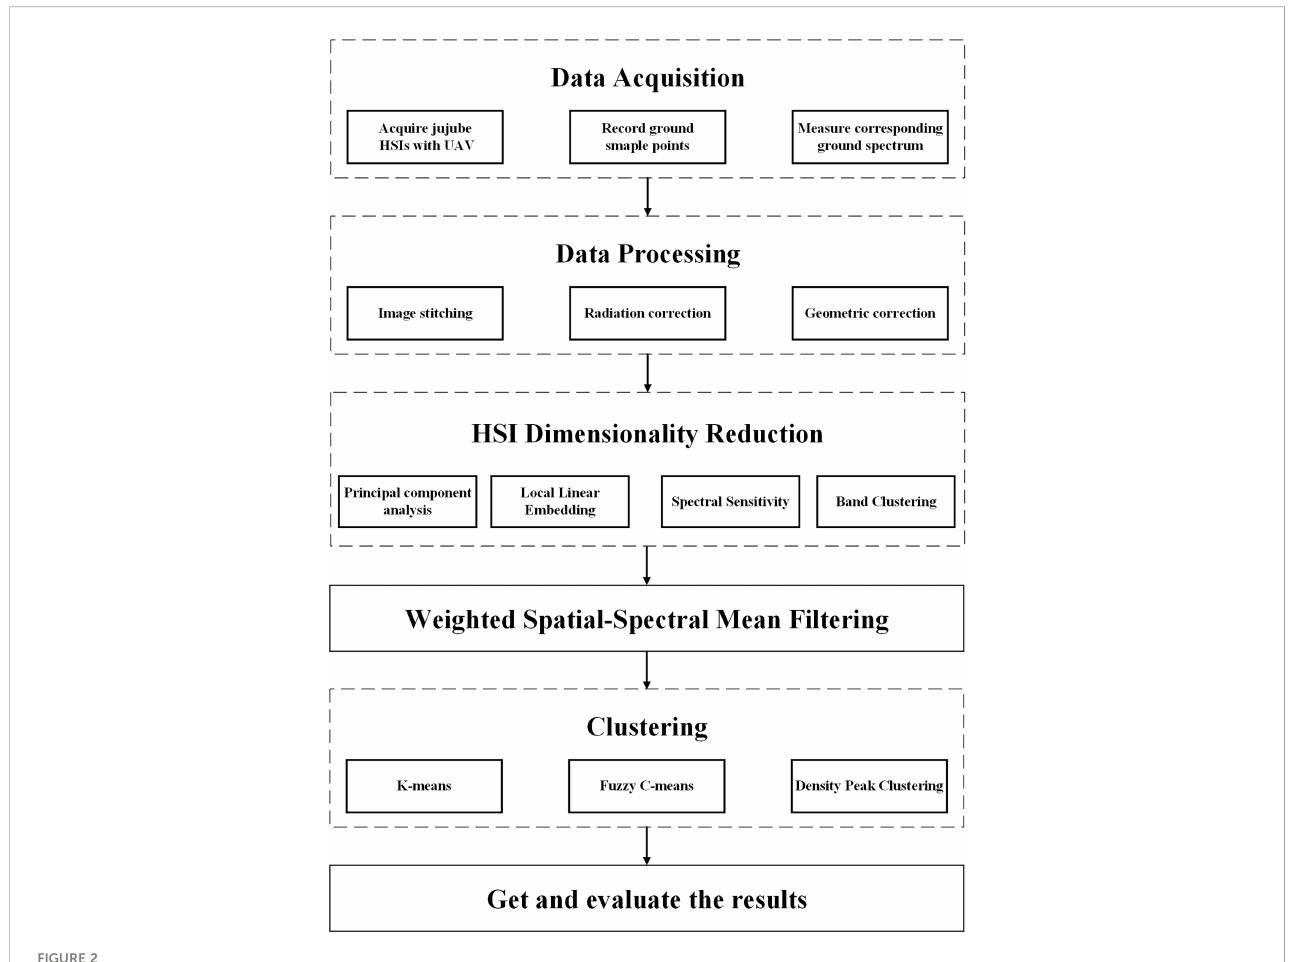
FIGURE 2 Flow chart of recognition of jujube spider mite